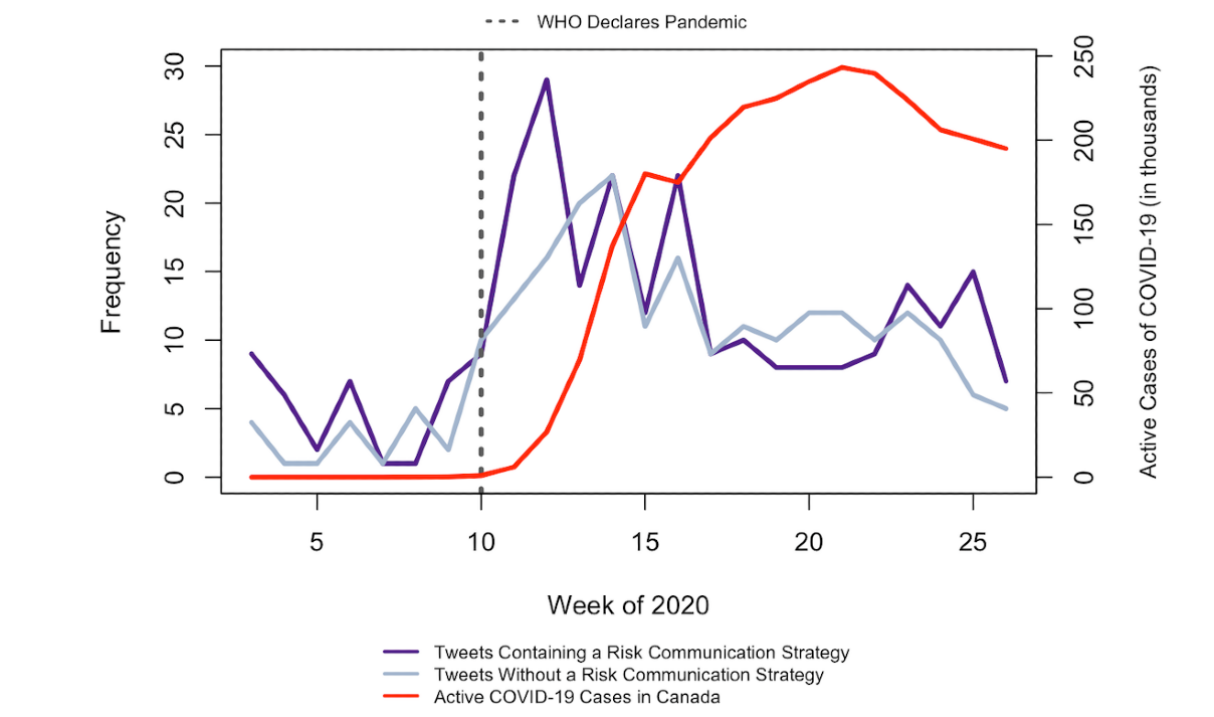
Figure 3. Weekly frequency of COVID-19 tweets containing any risk communication strategy, across all account types, January 1, 2020, to June 30, 2020. WHO: World Health